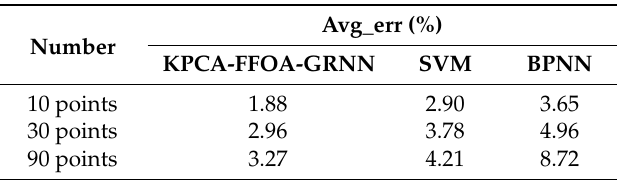
Table 3. Prediction error for different amount of test set